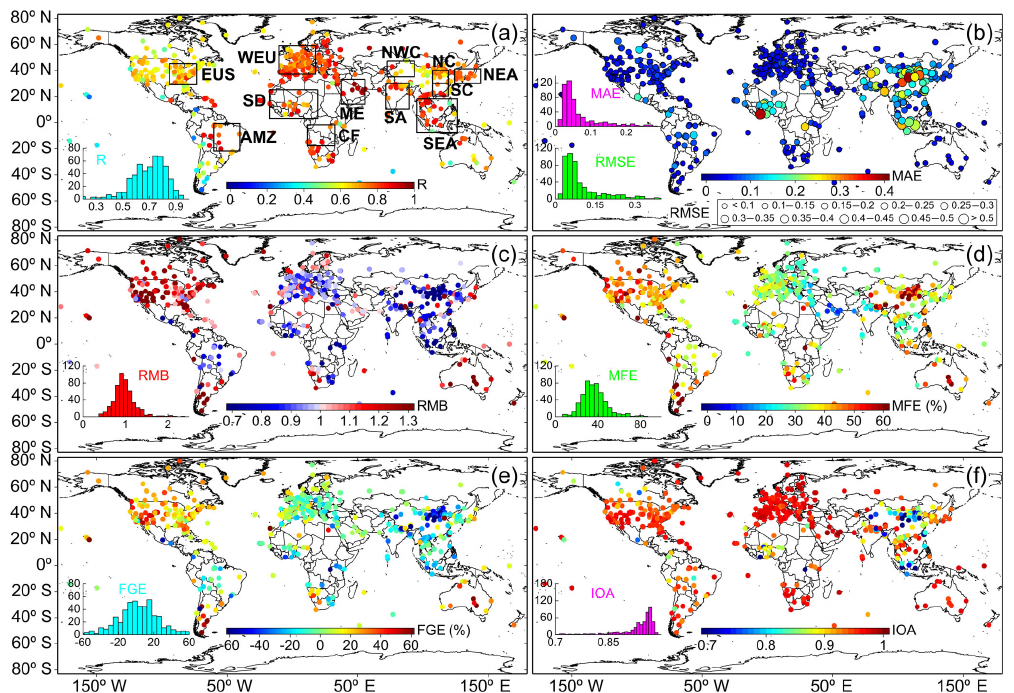
Figure 4. Comparison of the 3-hourly MERRA-2 AOD datasets with AOD observations of 468 AERONET sites worldwide and 37 CARSNET sites in China: site performance maps for the (a) correlation coefficient ( R ), (b) mean absolute error (MAE), root-mean-square error (RMSE), (c) relative mean bias (RMB), (d) mean fractional error (MFE), (e) fractional gross error (FGE), and (f) the index of agree- ment (IOA) between MERRA-2 AOD and ground-based AOD observations. The size of the circles in (b) represents the RMSE and their inner color represents the MAE. The bars in the lower-left inset in each panel represent the frequency distribution histograms for the R , MAE, RMSE, RMB, MFE, FGE and IOA between MERRA-2 and all ground-based observations incorporating AERONET and CARSNET, respectively. Note that all sites within each region of interest (ROI) are integrated to assess the accuracy of the MERRA-2 AOD dataset in that area. The performance of the MERRA-2 AOD dataset in each ROI is illustrated in Figs. S2 and